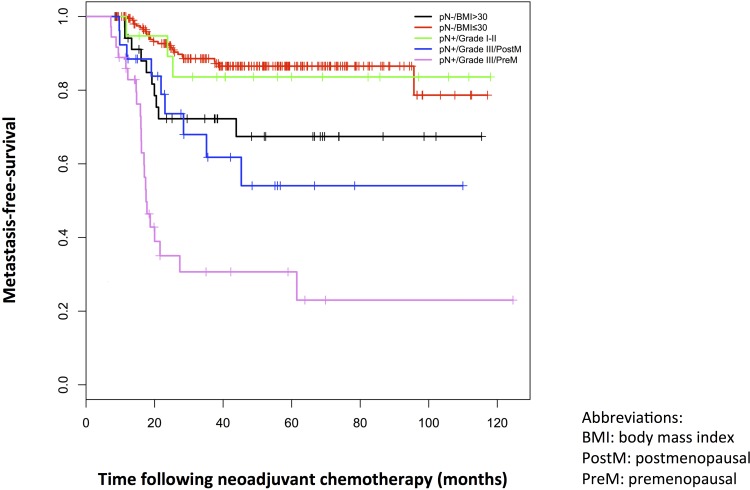
Kaplan-Meier plots of metastasis-free survival for each subgroup of the decision tree in the NEOREP Cohort.Abbreviations: BMI, body mass index; PostM, postmenopausal; PreM, premenopausal.